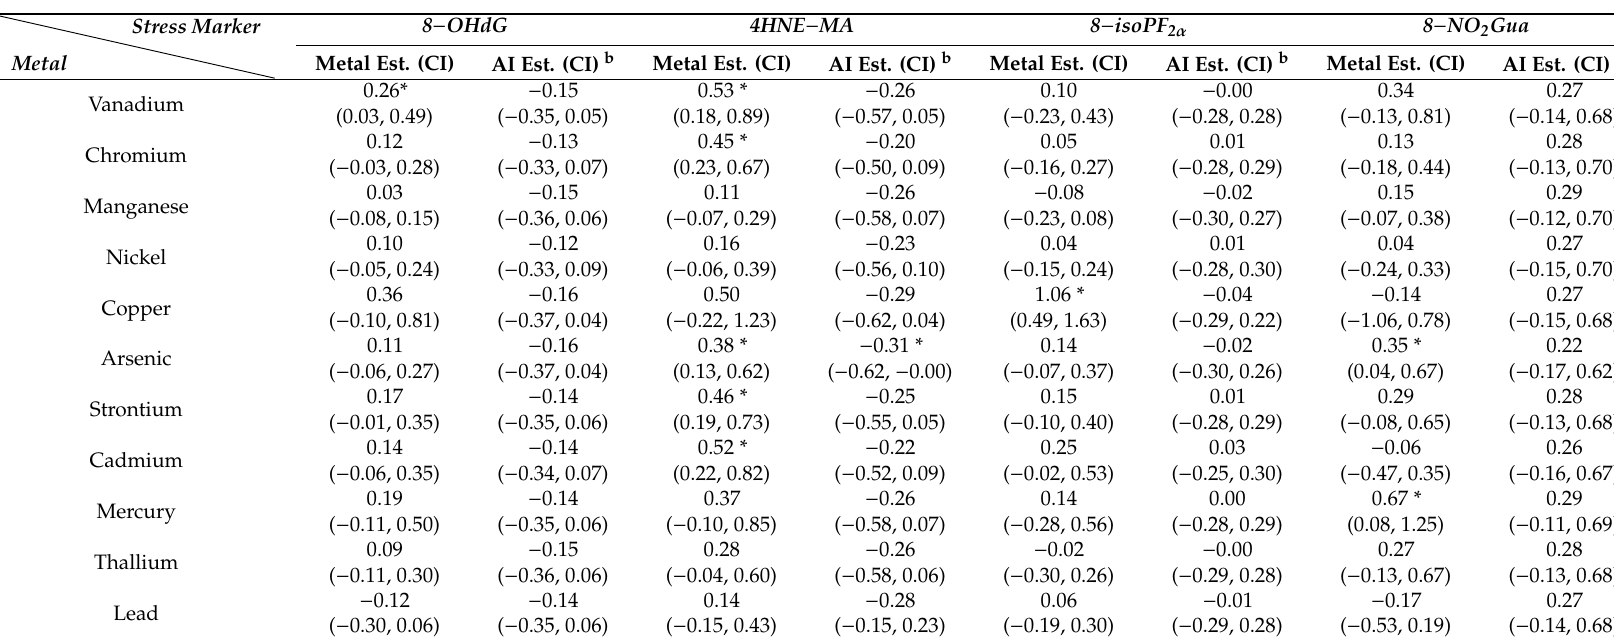
Table 5. The associations between heavy metal exposure and oxidative stress with the antioxidant intake for study subjects in low exposure group (n = 68).